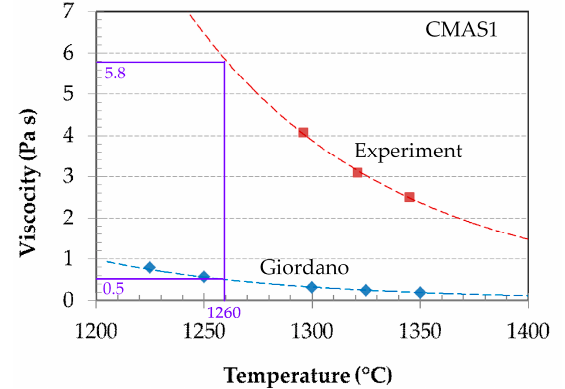
Figure 8. Viscosities for CMAS1 measured experimentally and using the Giordano (GRD) model at different temperatures.